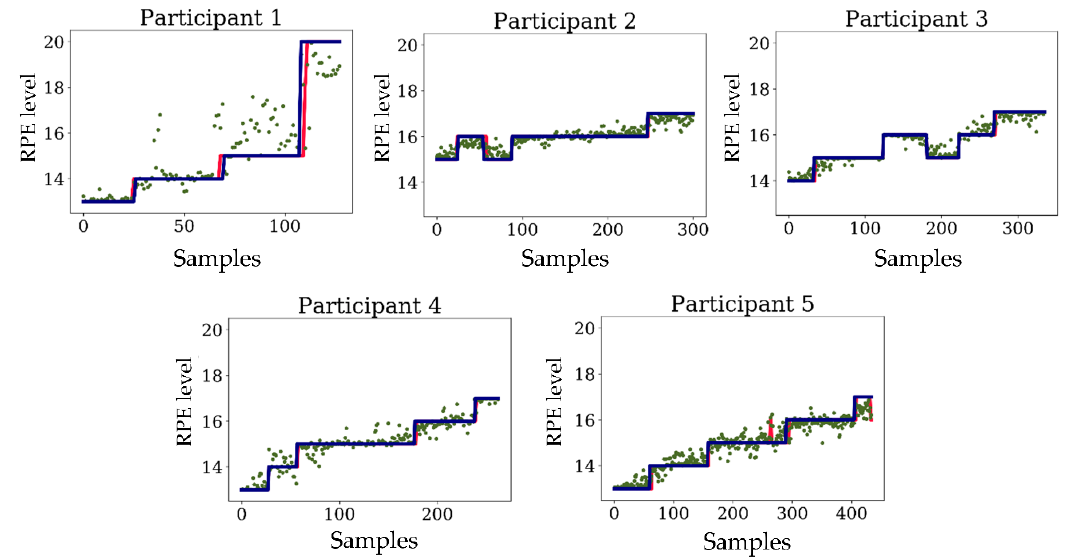
Figure 4. The output of the first level regressor and final prediction of RPE level.